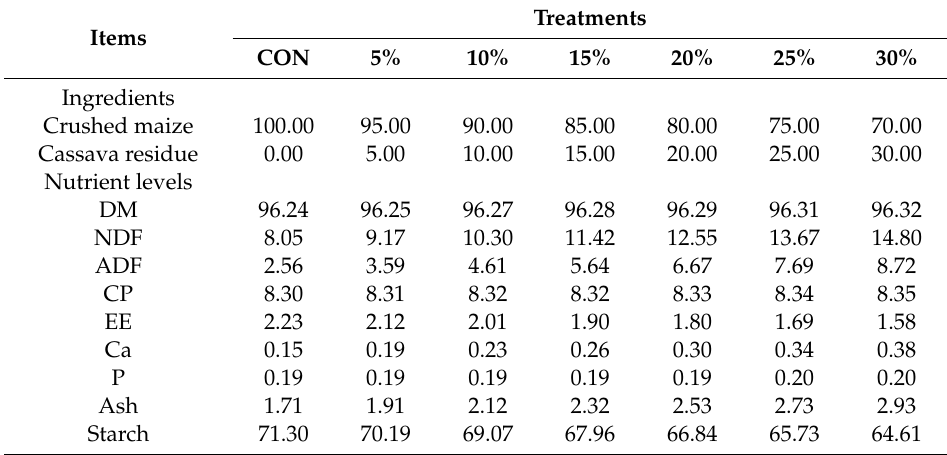
Table 2. Ingredients composition and nutrient content of fermentable substrates in each treatment (air-dried matter basis,